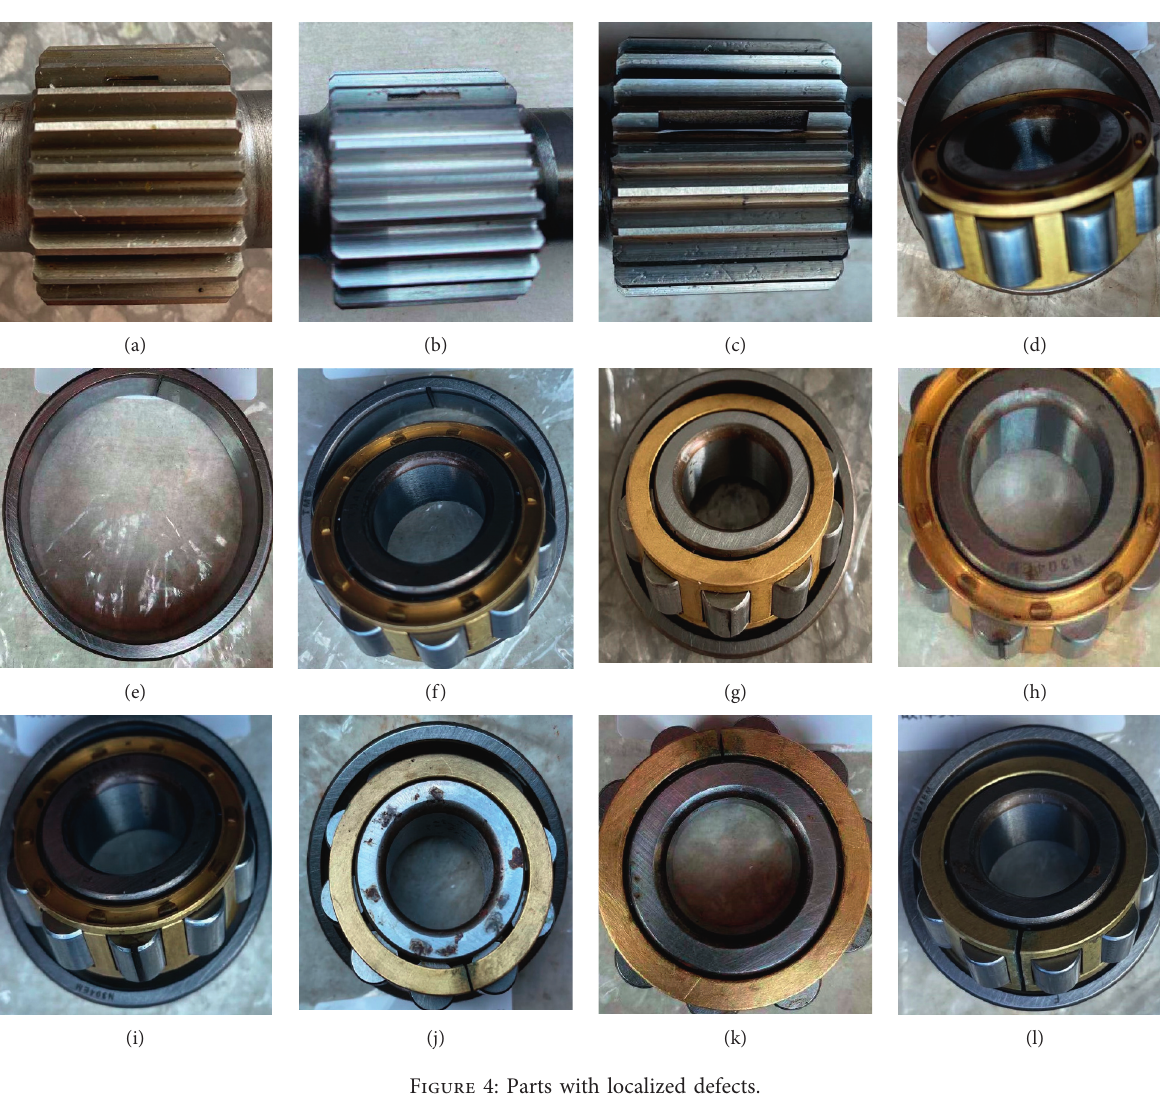
Figure 4: Parts with localized defects.